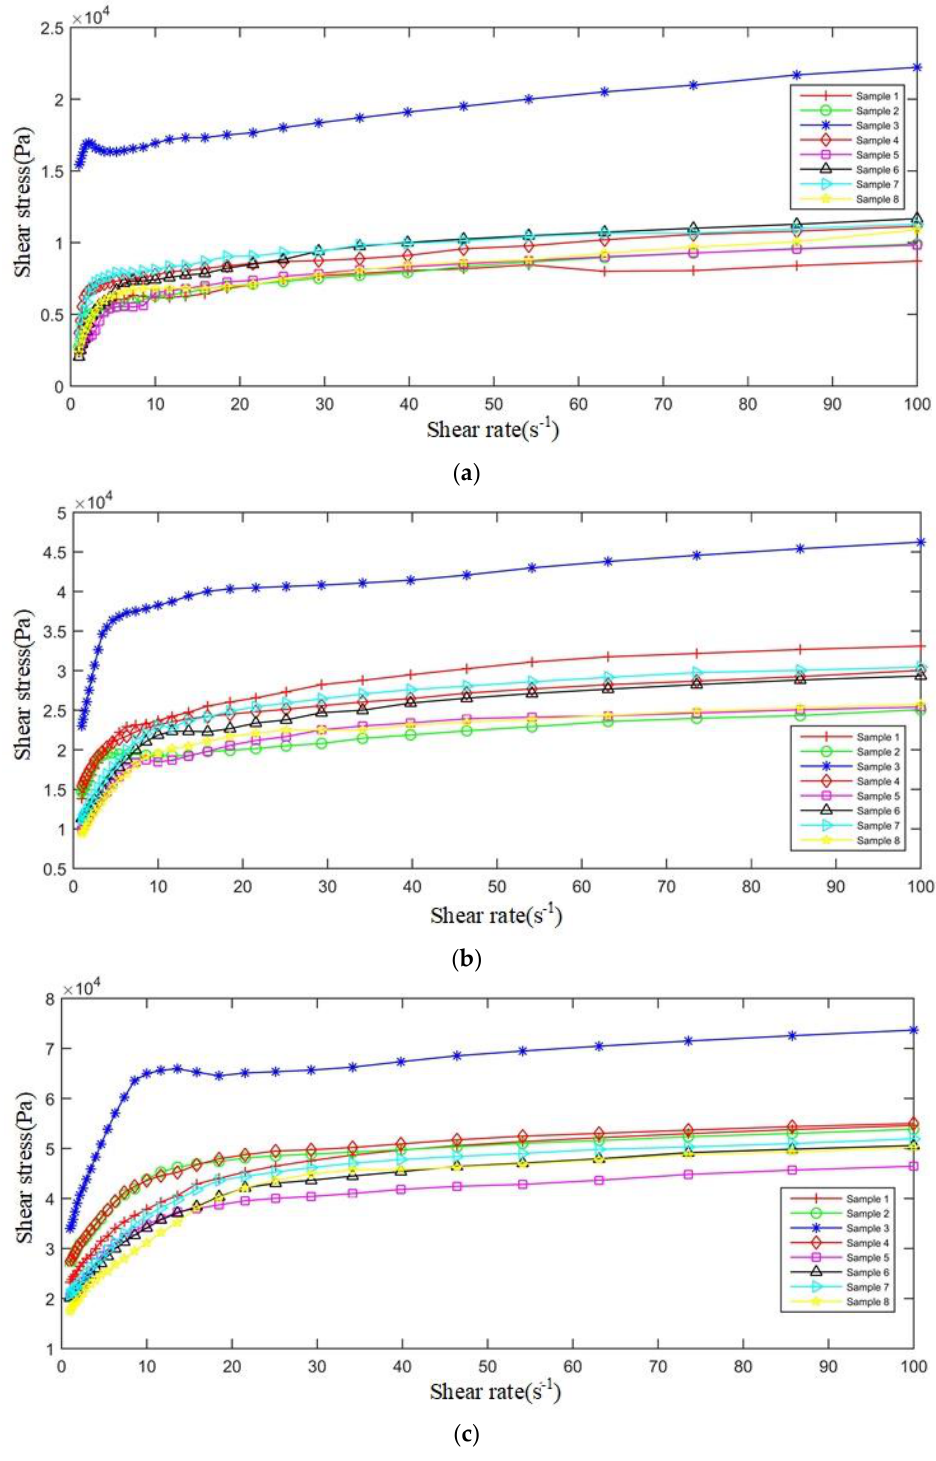
Figure 5. Relationship between shear stress and shear rate with different magnetic flux densities. ( a ) magnetic flux density is 0.2 T. ( b ) magnetic flux density is 0.4 T. ( c ) magnetic flux density is 0.6 T.